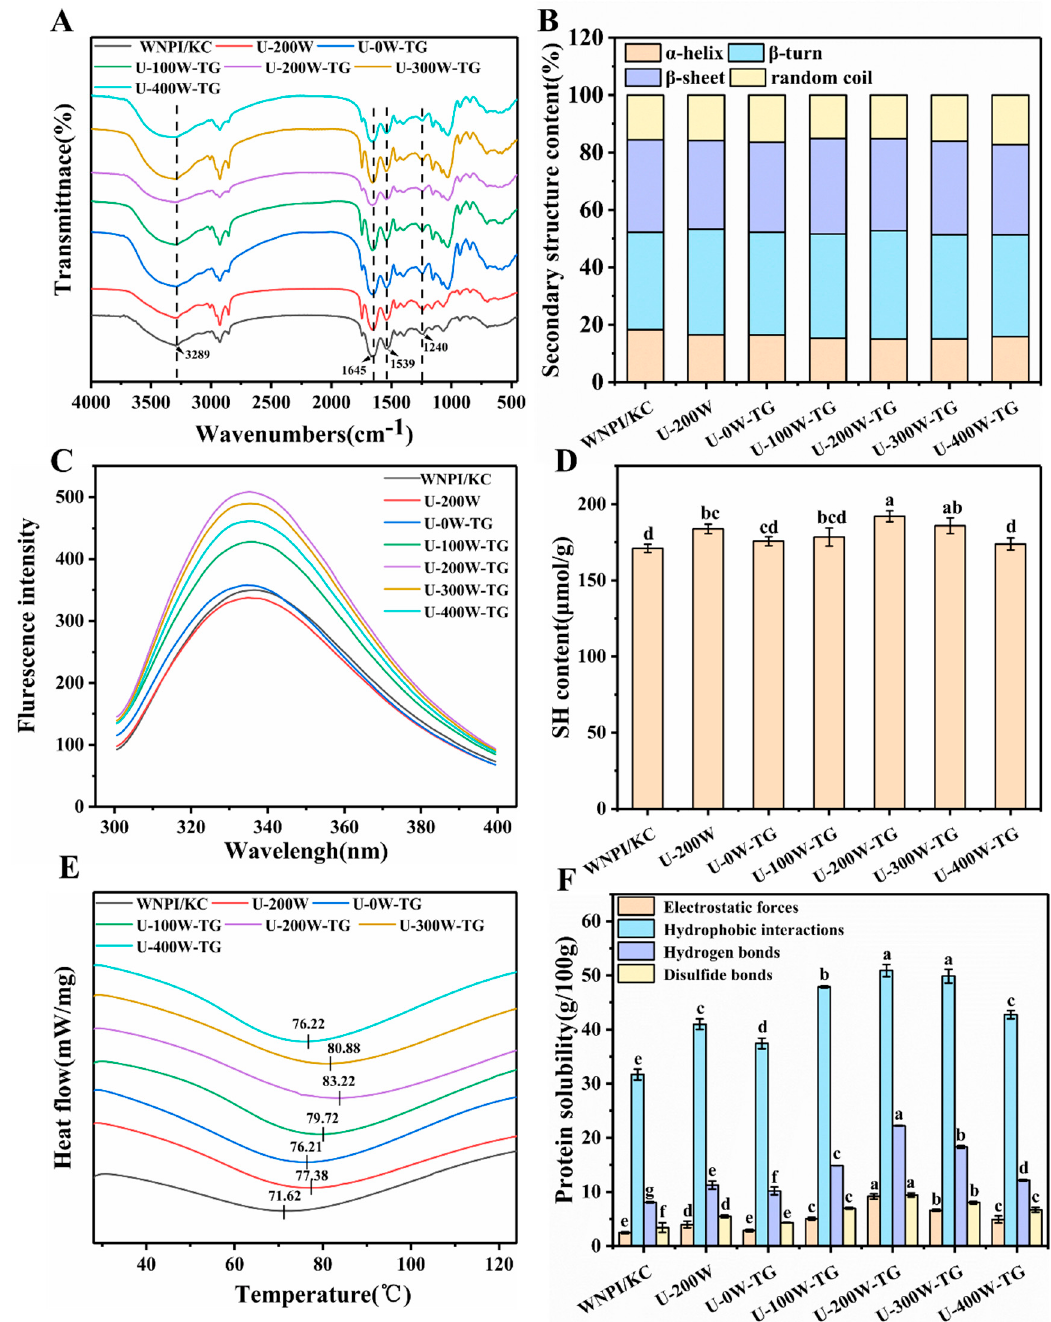
Figure 6. Effects of ultrasonic power on infrared spectra ( A ), secondary structure contents ( B ), fluorescence intensities ( C ), SH contents ( D ), thermal stability ( E ) and intermolecular forces ( F ) of WNPI-KC composite gels. Different letters on different color bars indicate significant differences ( p < 0.05).